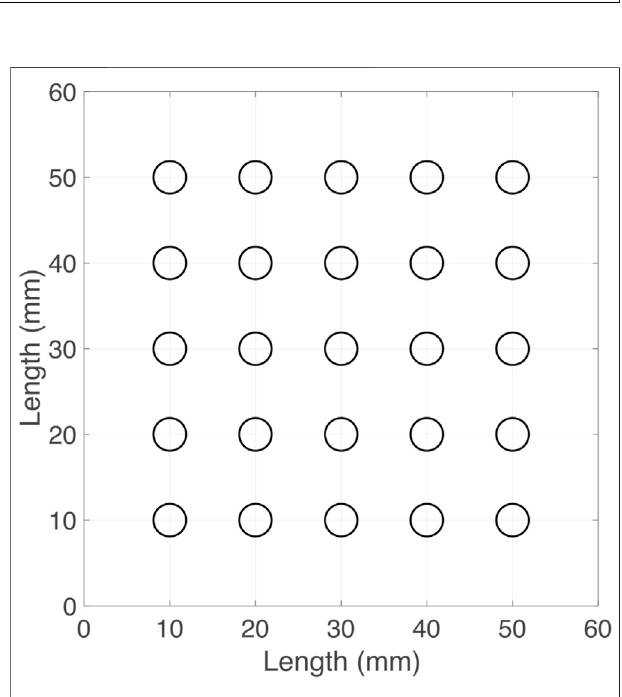
FIGURE 5 | The model for the